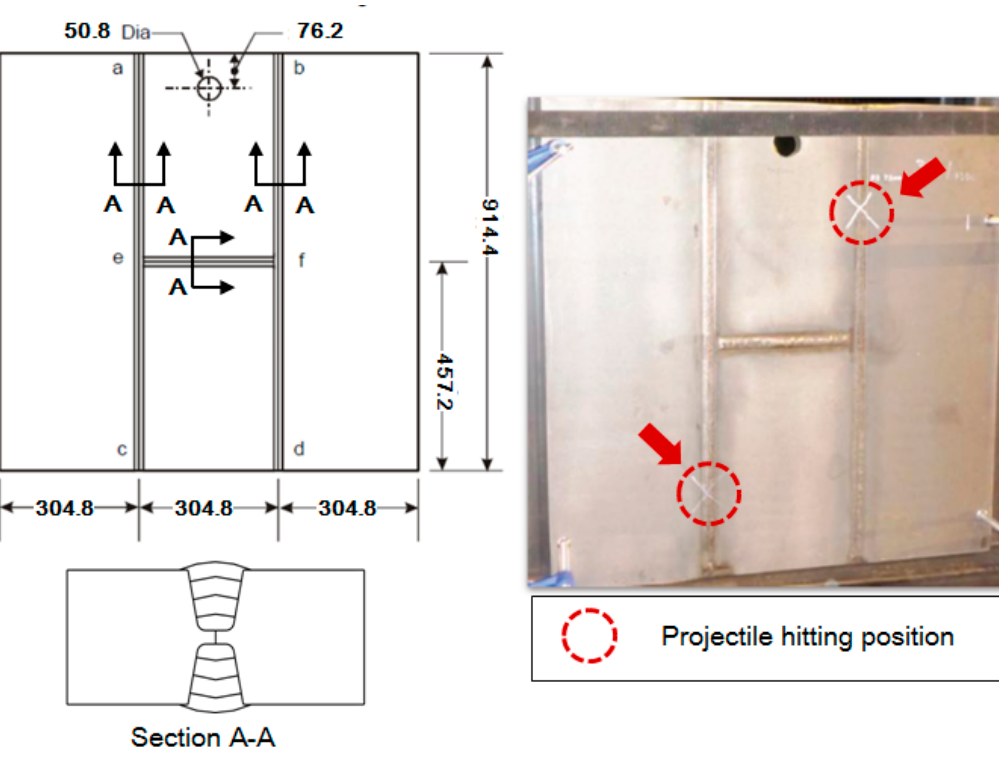
Figure 11. Illustration of the H-plate specimens and projectile hitting positions. Table 7. Requirements for the ballistic tests.